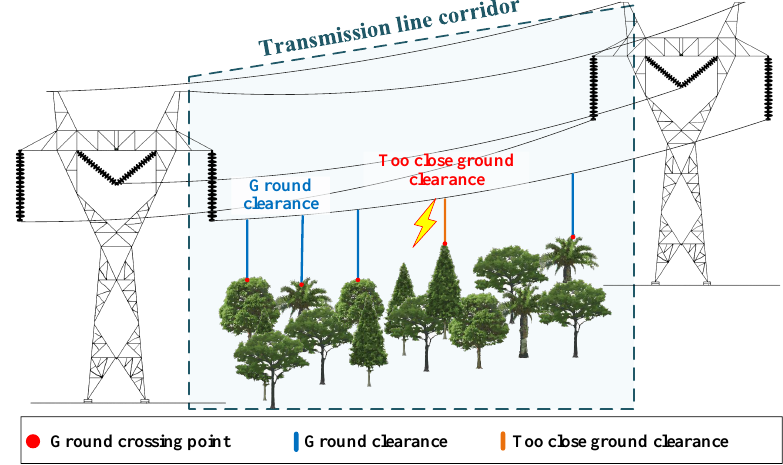
Figure 1. Schematic diagram of ground clearance of transmission